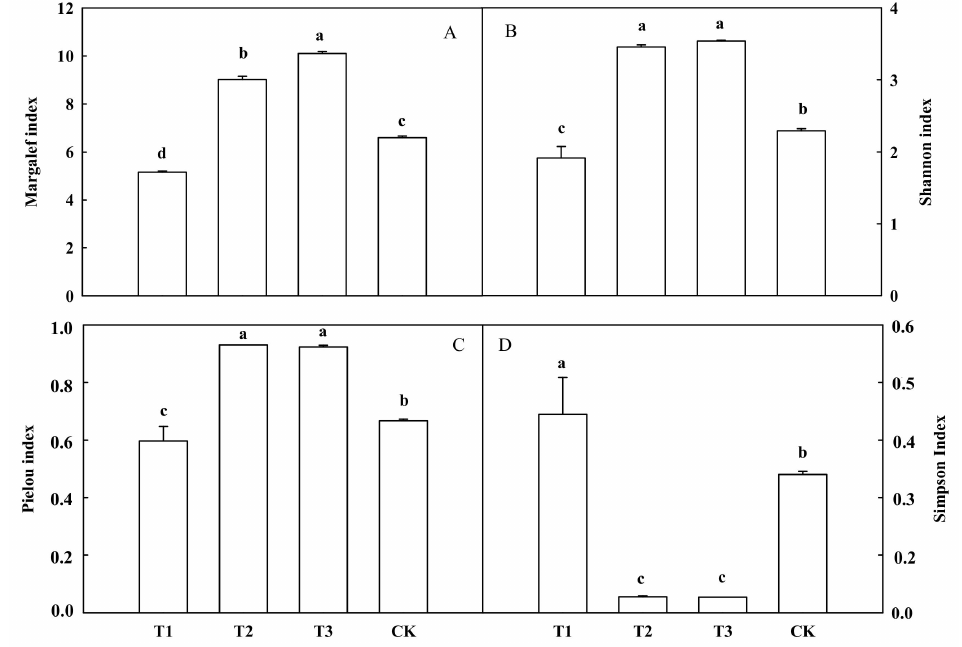
Figure 1. Species diversity of soil fungi. T1, the replanted soil fumigated with methyl bromide; T2, the replanted soil mixed cropping with A. fistulosum ; T3, the replanted soil mixed cropping with B. juncea ; CK: the replanted soil; ( A ), Margalef index of different soil samples; ( B ), Shannon index of different soil samples; ( C ), Pielou index of different soil samples; ( D ), Simpson index of different soil samples. Data are the means of three replicates ( ± SE), different letters indicate significant differences at p <